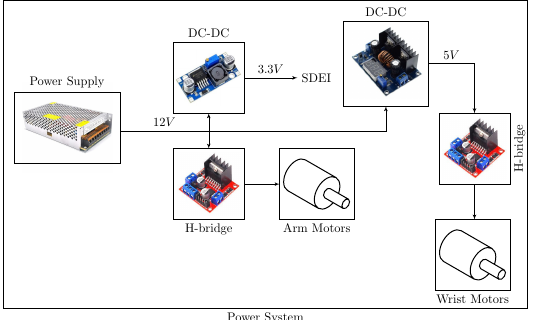
Figure 10. The power system.